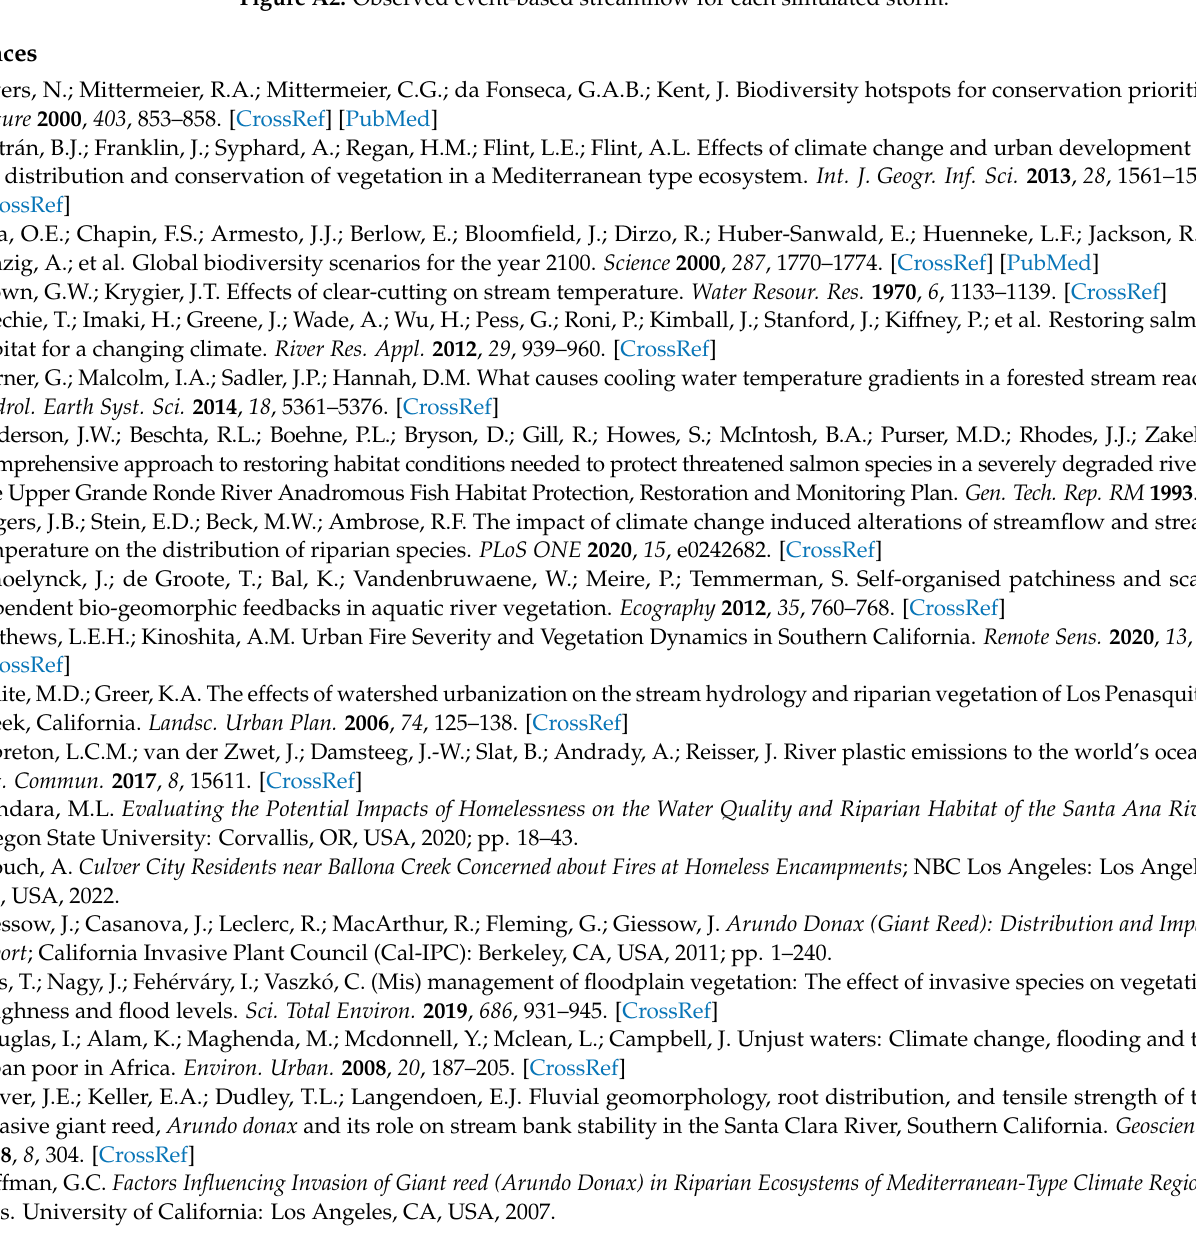
Figure A2. Observed event ‐ based streamflow for each simulated storm.